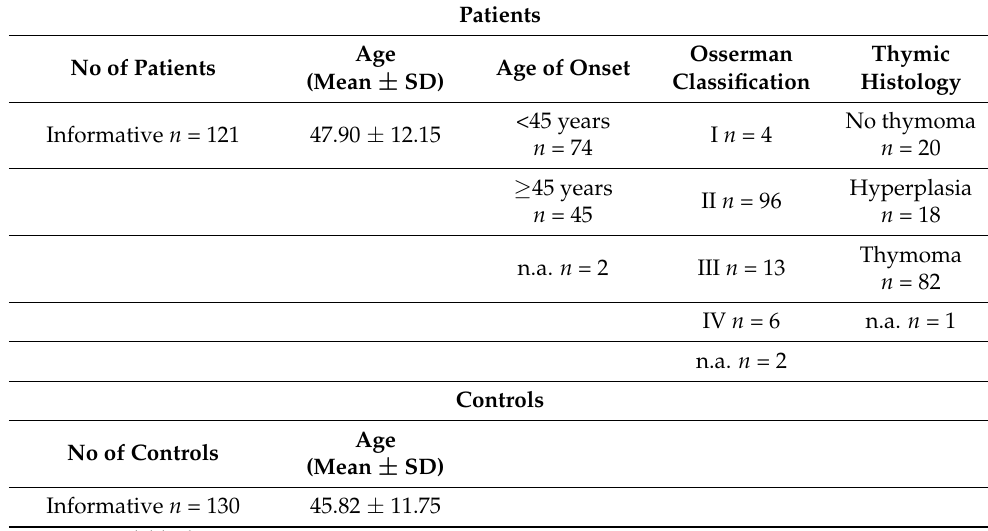
Table 1. Characteristics of cases and